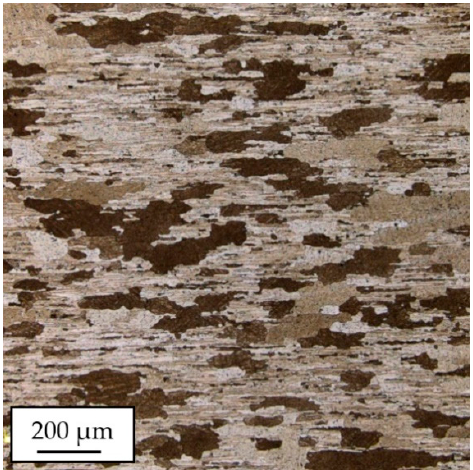
Figure 3. The microstructure of AA2519-T62 extrusion.